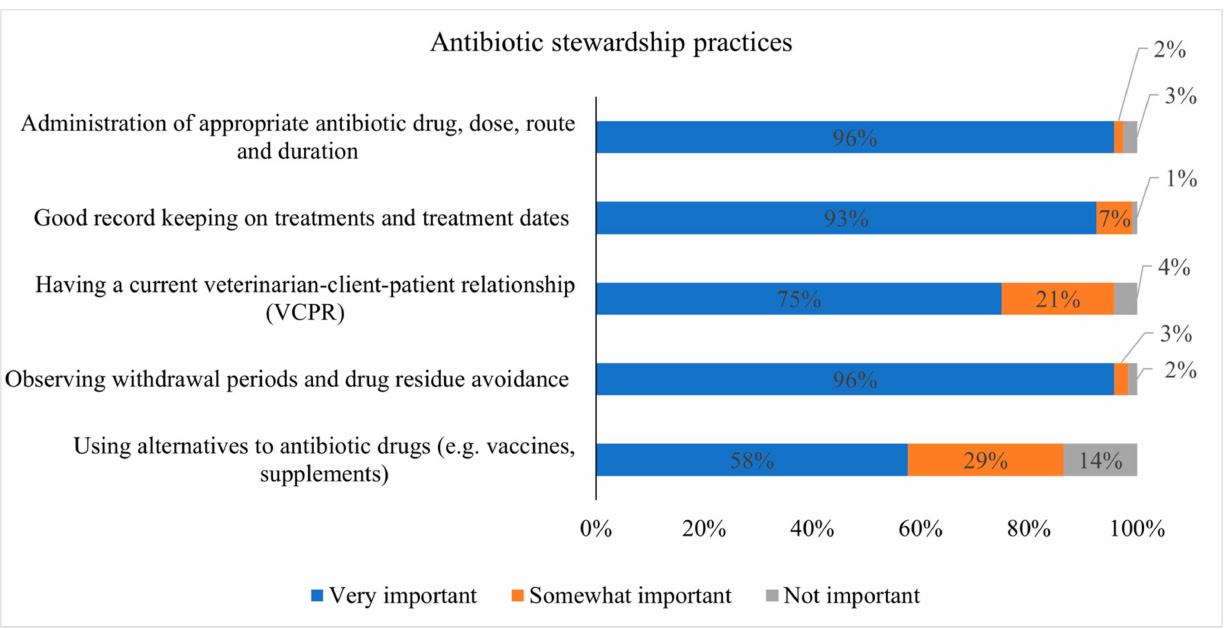
Figure 4. California dairy producers’ responses regarding antimicrobial drug use stewardship